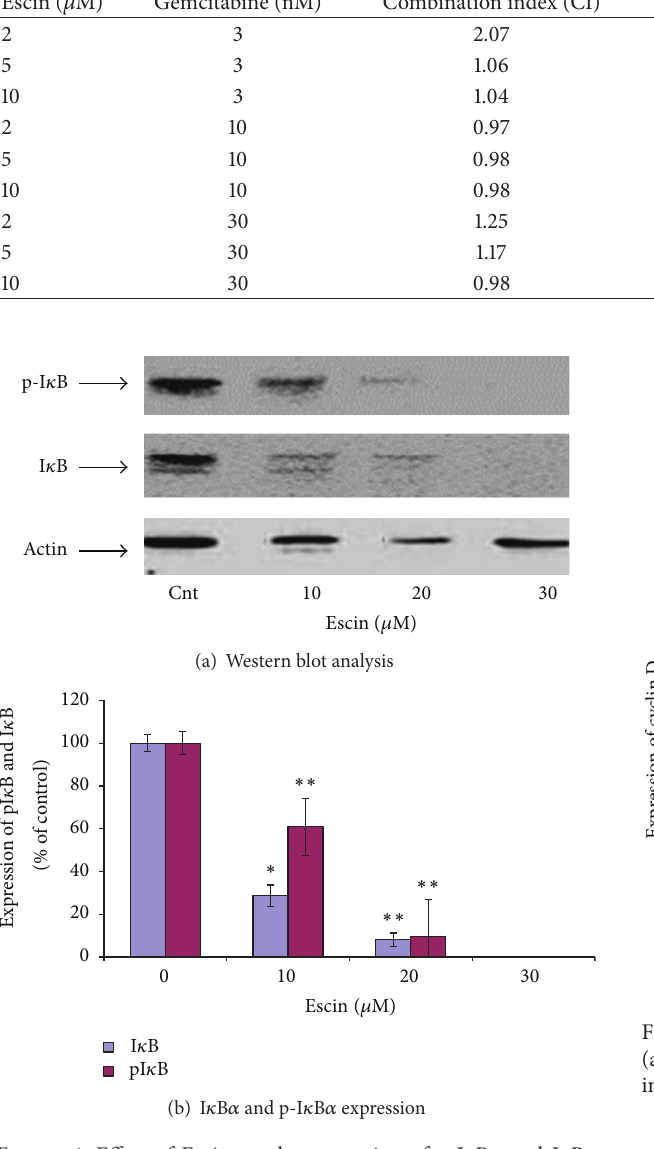
Figure 4: Effect of Escin on the expression of p-I 𝜅 B 𝛼 and I 𝜅 B 𝛼 in Panc-1 cells. (a) Western blot analysis. (b) Densitometry results averaged from 3 independent experiments. # The expressions of p- I 𝜅 B 𝛼 and I 𝜅 B 𝛼 were not detectable with Escin 30 𝜇 M.